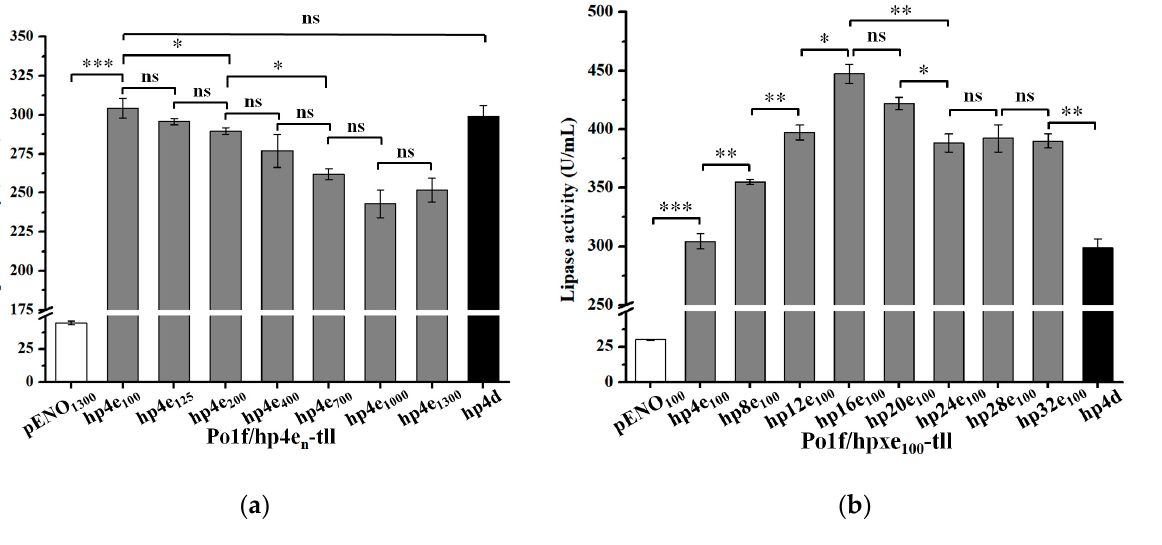
Figure 3. TLL activity of recombinant strains ( a ) Po1f/hp4e n -tll (n = 100, 125, 200, 400, 700, 1000, and 1300 bp) and ( b ) Po1f/hpxe 100 -tll (x = 8, 12, 16, 20, 24, 28, and 32). Statistical significance was calculated by unpaired T-test analysis. ns: no significant difference; *: p < 0.05; **: p < 0.01; ***: p <